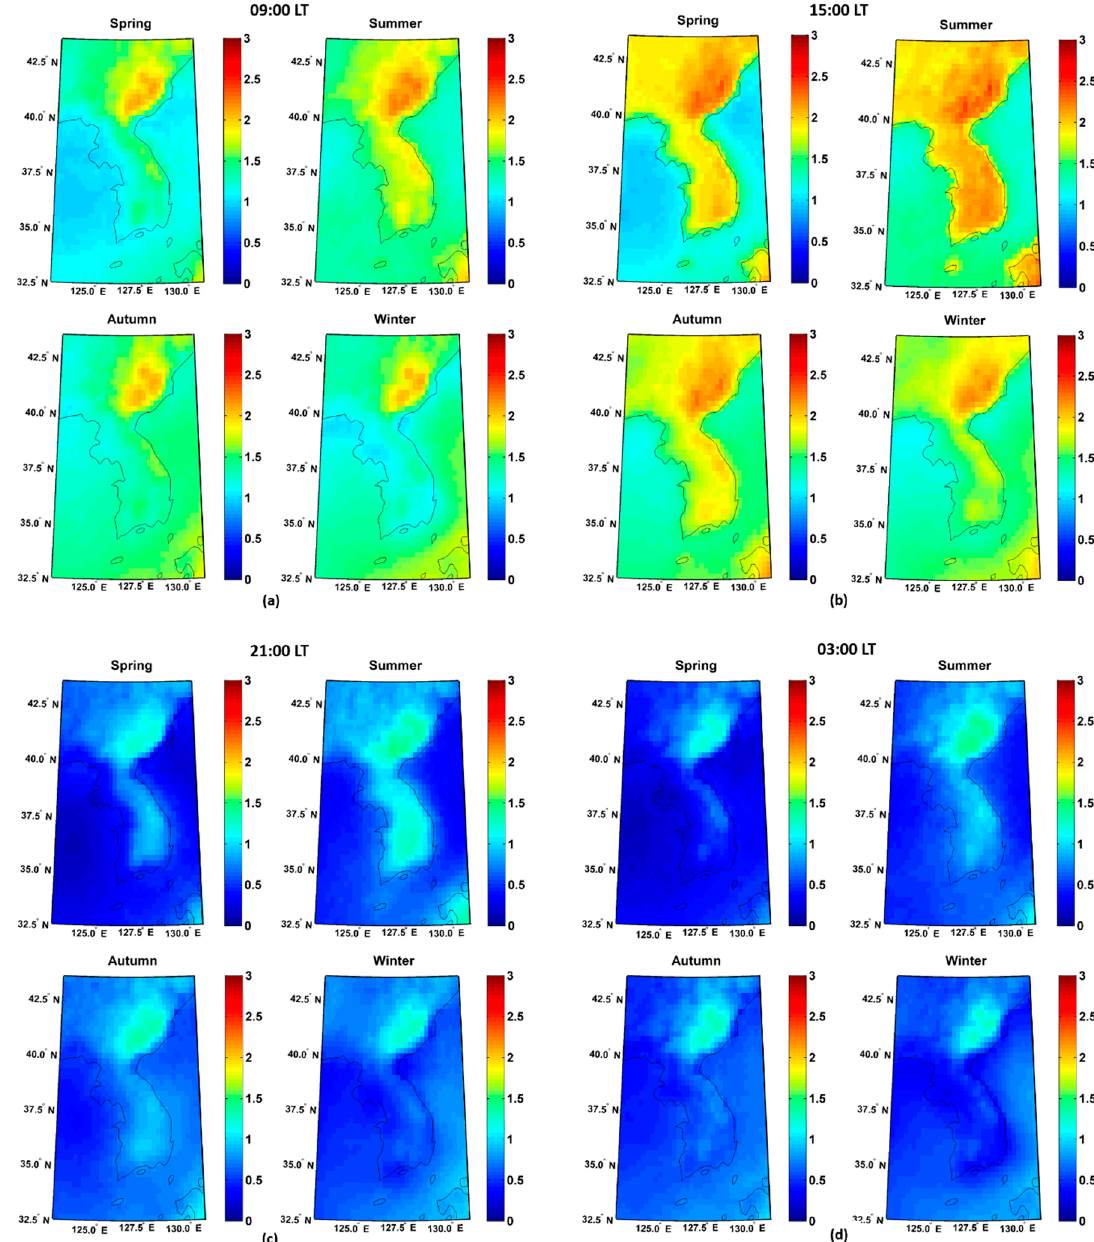
Figure 4. Spatial distribution of average PBLH from 2008 to 2017: ( a ) 09:00 LT, ( b ) 15:00 LT, ( c ) 21:00 LT, and ( d ) 03:00 LT.